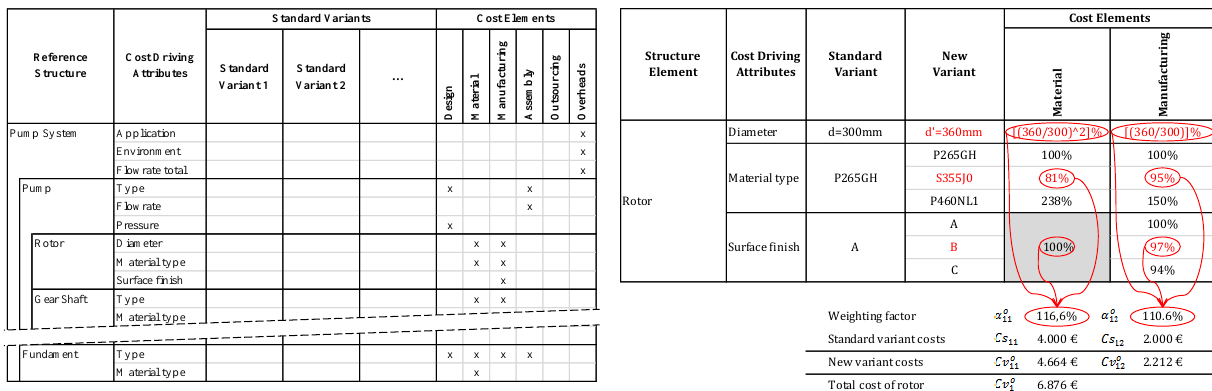
Table 2: Cost estimation of a new rotor variant.